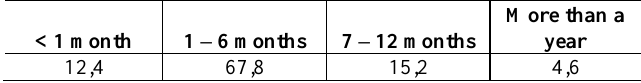
Table 3: Time taken to recognise there was a problem